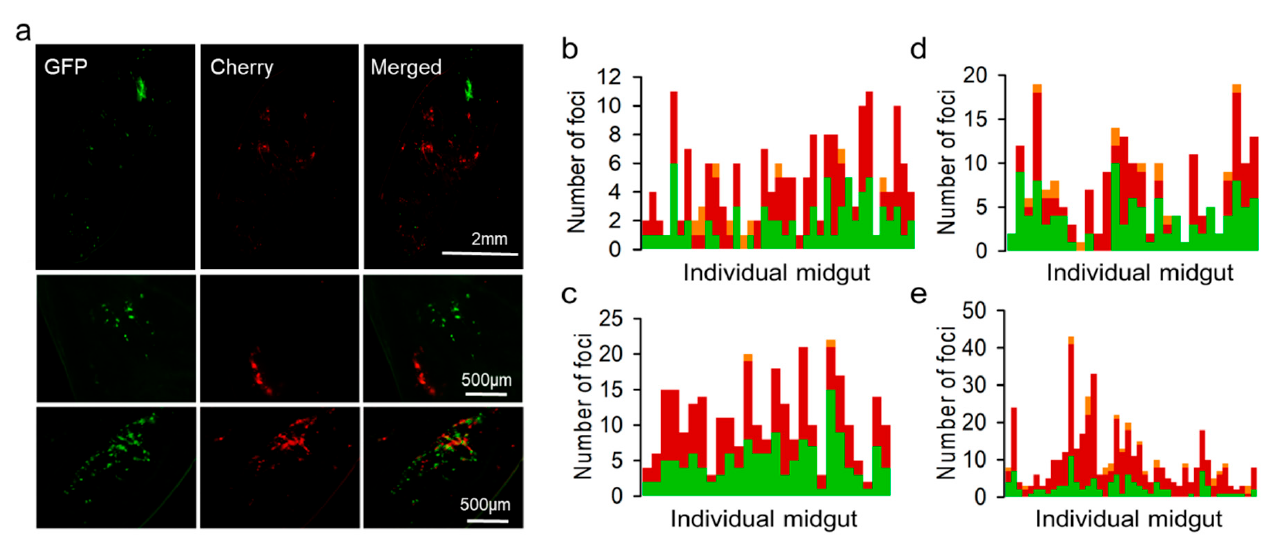
Figure 3. Microscopic examination of midgut infection foci at 72 hpi. ( a ). Representative images of full midguts (top) and individual foci showing segregated (middle) or co-localizing (bottom) GFP and Cherry reporters. ( b ). Analysis of larvae inoculated with OBs prepared from coinfected Sf21 cells (F1). Each bar represents the midgut of an individual larva and the stacked colors indicate the numbers of GFP-positive (green), Cherry-positive (red), and doubly fluorescent (orange) foci. ( c ). Analysis of larvae inoculated with F2 viruses (i.e., OBs released by F1). ( d ). Larvae inoculated with OBs prepared from Sf21 cells coinfected with a polyhedrin-defective GFP virus and a complete Cherry virus (F1). ( e ). Analysis of larvae inoculated with F2 viruses derived from the F1 polyhedrin-defective GFP virus and complete Cherry virus infection.